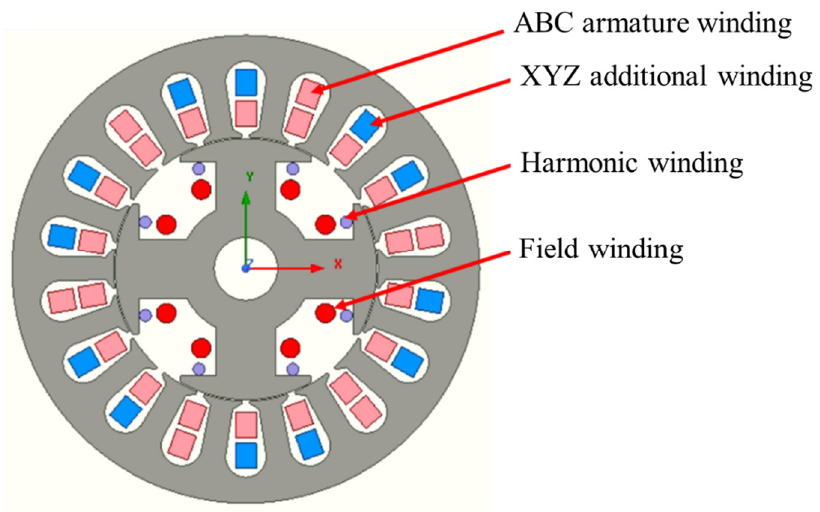
Figure 1. Schematic diagram of the proposed brushless WRSM.